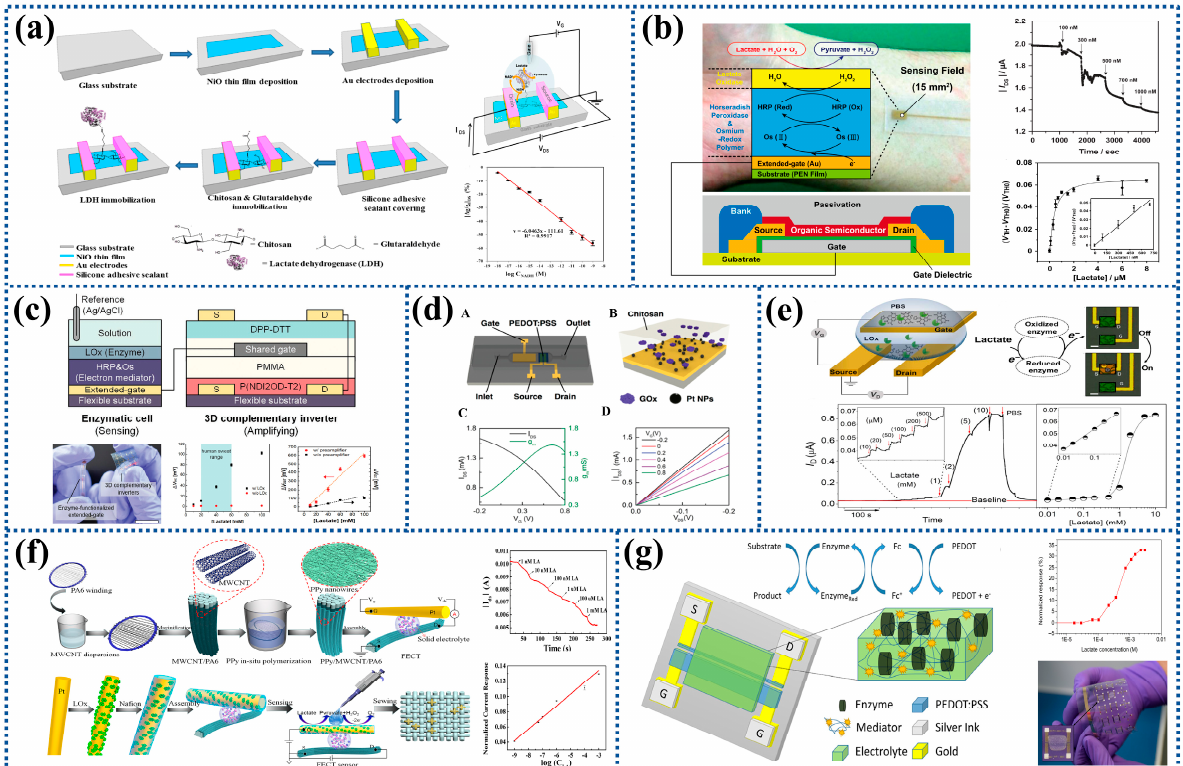
Figure 6. Preparation process and characterization of semiconductor biosensors for lactate detection: ( a ) Nickel oxide thin − film field − effect transistor based on radio frequency. Reprinted with permission from ref. [117]. Copyright 2017 Else- vier. ( b ) An extended − gate type OFET for lactate detection in aqueous media. Reprinted with permission from ref. [121]. Copyright 2015 Elsevier. ( c ) An organic voltage amplifier for lactate sensor on flexible plastic foil. Reprinted with permis- sion from ref. [123]. Copyright 2020 WILEY − VCH. ( d ) OECT used as highly sensitive lactate sensors by modifying the gate electrode with LOx and poly(n − vinyl − 2 − pyrrolidone) − capped Pt NPs. (A) Schematic diagram of lactate sensor based on OECT integrated with microfluidic channel (LOx solution was used instead of GOx solution). (B) Gate electrode modifi- cation of device. (C) Transfer curve and corresponding transconductance curve of an OECT. (D) Output curve of OECT.